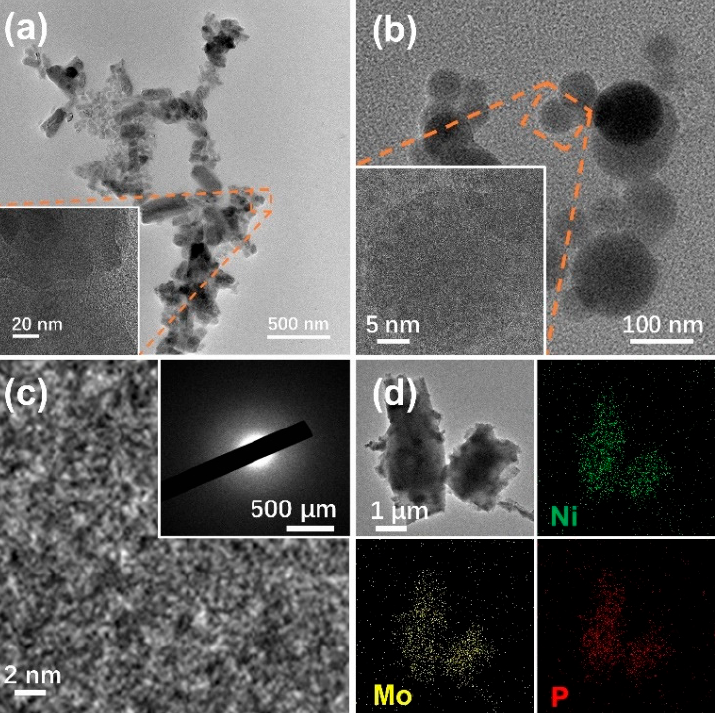
Figure 2. ( a – c ) TEM images of NiMoP/NF; ( d ) TEM–EDS elemental mapping images of NiMoP/NF.